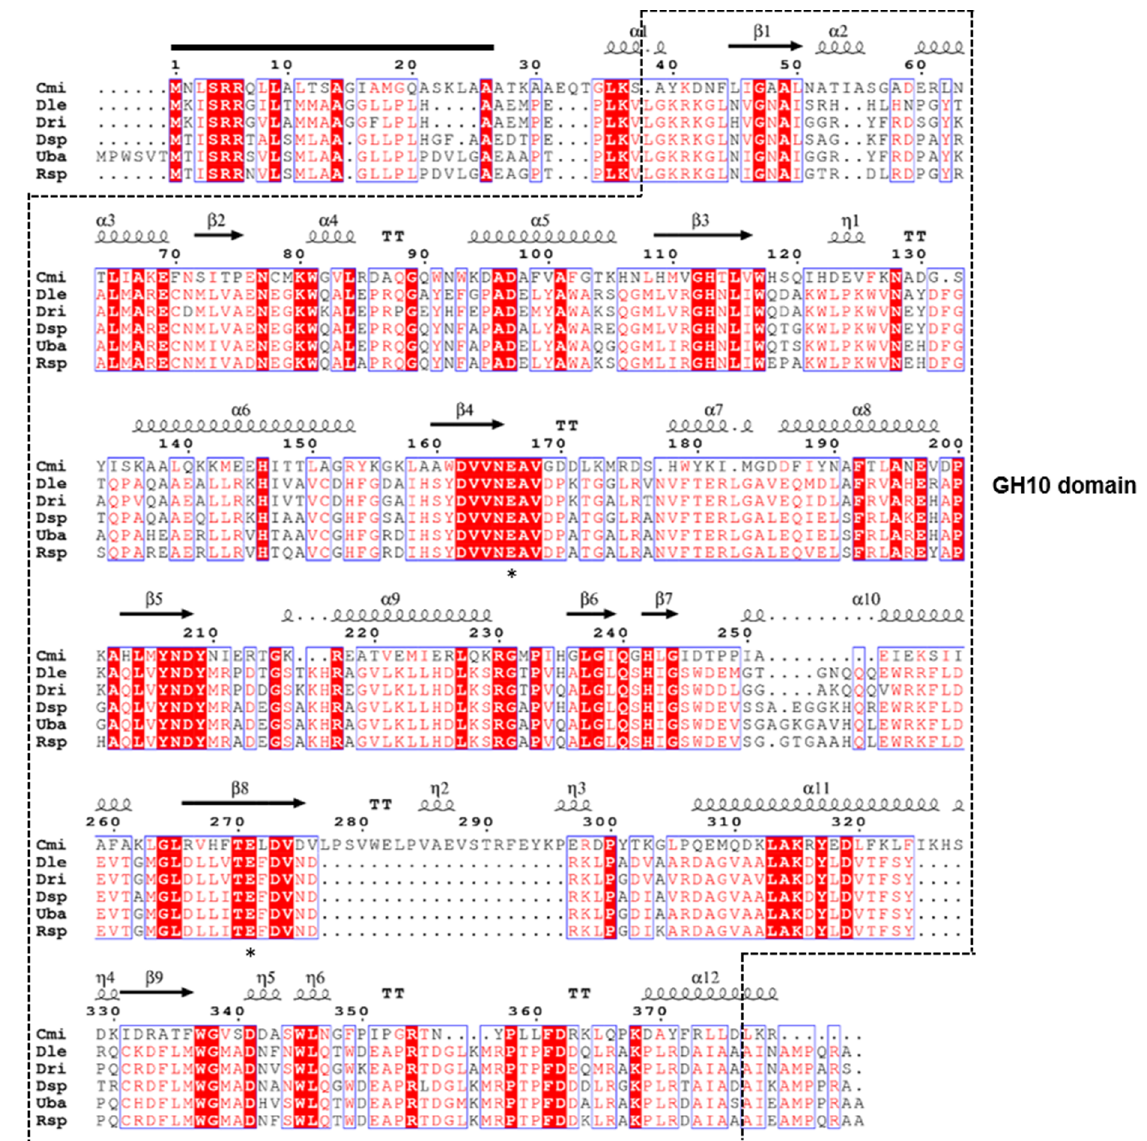
Figure 1. Molecular structure of Duganella sp. PAMC 27433 GH10 endo- β -1,4-xylanase and structure-based sequence alignment of the enzyme with its structural homologs. The first line shows the secondary structure elements ( α -helix, squiggle; β -strand, arrow; 3 10 -helix, η ; β -turn, TT) of Cellvibrio mixtus ATCC 12,120 endo- β -1,4-xylanase (PDB code: 1UQY) used as a template. Sequences (GenBank accession numbers): Cmi, Cellvibrio mixtus ATCC 12,120 endo- β -1,4-xylanase (AAD09439); Dle, Duganella levis endo- β -1,4-xylanase (WP_161054863); Duganella rivi β -1,4-xylanase (WP_154357092); Duganella sp. PAMC 27433 GH10 endo- β -1,4-xylanase (MW735678); uncultured bacterium BLR13 endo- β -1,4-xylanase A precursor (ACN58881); and Rugamonas sp. SG757 endo- β -1,4-xylanase (WP_176653060). The predicted signal peptide is indicated by a black bar and GH10 domain is outlined by dotted line. Highly conserved amino acid residues, which play an important role in biocatalytic reaction, are displayed by